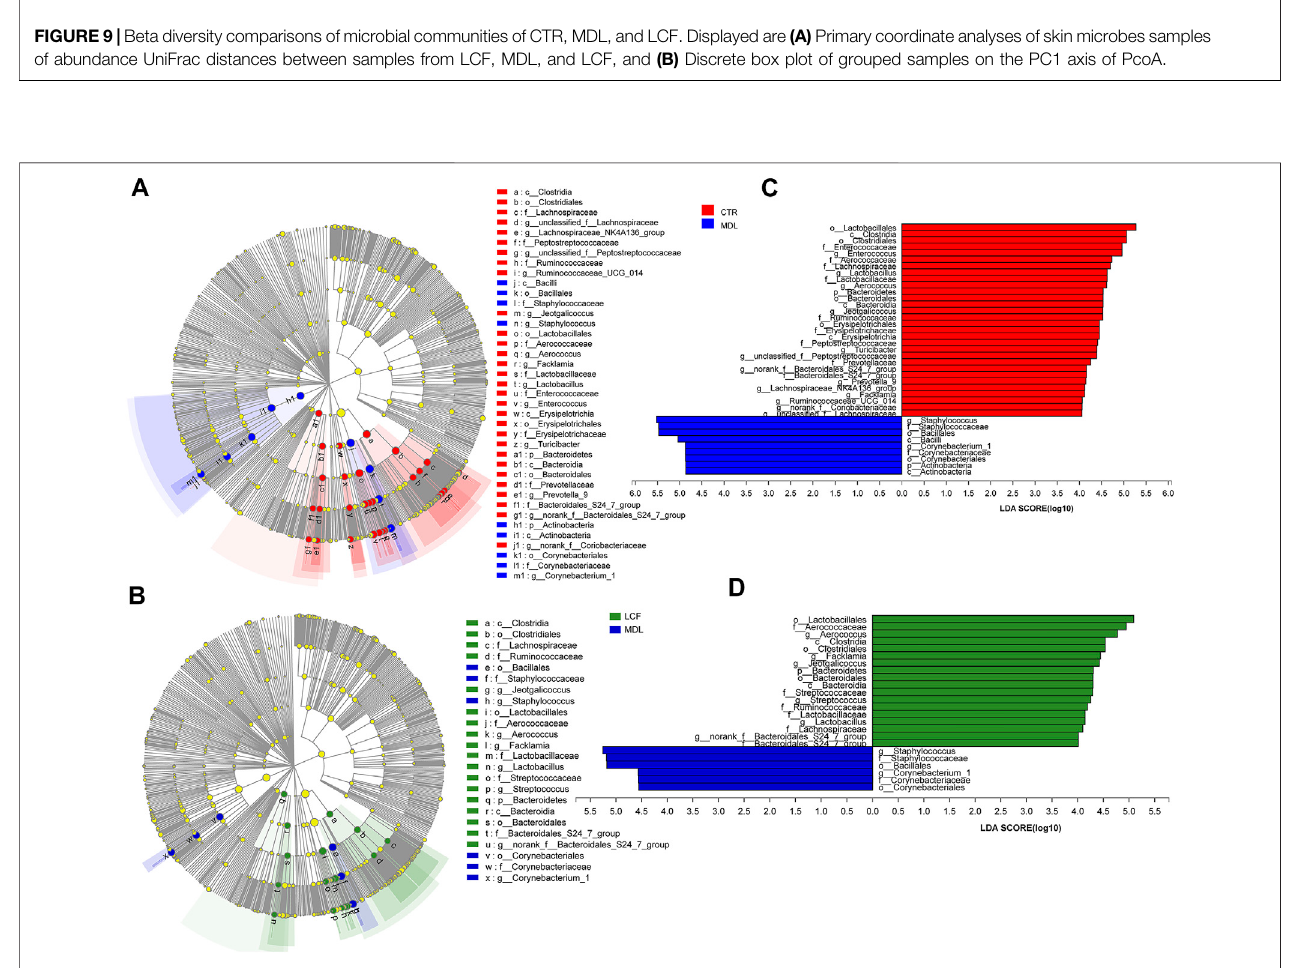
FIGURE 10 | Key bacterial alterations in response to the acne and LCF treatments. (A) Cladogram generated by the LEfSe analysis (LDA = 4) showing enriched or depletedtaxainratskinsamplesfromtheCTR(red)andMDL(blue)groups. (B) CladogramgeneratedbytheLEfSeanalysis(LDA=4)showingenrichedordepletedtaxa inratskinsamplesfromtheLCF(green)andMDL(blue)groups. (C) LDAscoresofenrichedtaxaareshownin (A) . (D) LDAscoresofenrichedtaxaareshownin (B) . n (cid:1) 8 rats per group.